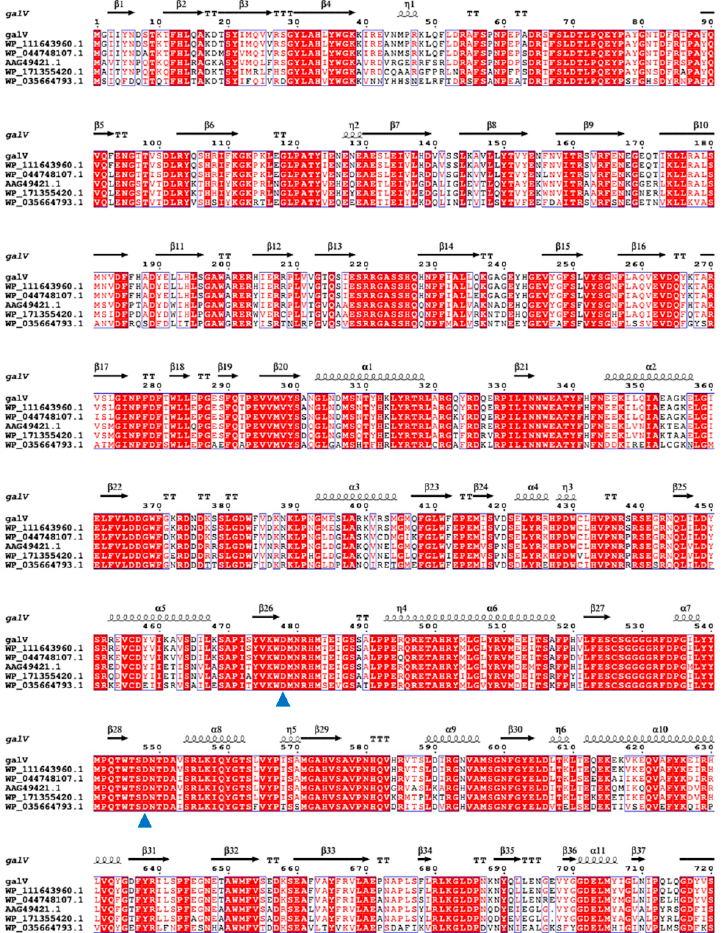
Figure 2. Multiple sequence alignment of galV and its homologs. Proteins in the alignment are GH36 α -galactosidases from Anoxybacillus vitaminiphilus , Bacillus alveayuensis , Geobacillus sp. MR, Alkalihalobacillus akibai and Geobacillus stearothermophilus . Blue triangles indicate putative nucleophile residues and acid/base catalytic residues.